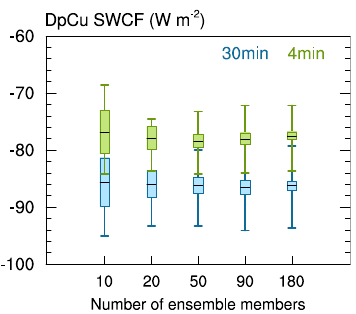
Figure 7. Shortwave cloud forcing (SWCF) associated with tropical Fig. 7. Shortwave cloud forcing (SWCF) associated with tropical deep convection in simulations performed with 30 (blue) and 4min deep convection in simulations performed with 30min (blue) and (green) time steps. The SWCF is averaged over tropical ocean grid 4min (green) time steps. The SWCF is averaged over tropical ocean points, where the daily mean convective precipitation rate exceeds grid points where the daily mean convective precipitation rate ex- 3mm day − 1 . Like in Fig. 4, horizontal bars in the middle of filled ceeds 3 mmday − 1 . Like in Fig. 4, horizontal bars in the middle boxes indicate the mean value of each ensemble. Lower and upper of filled boxes indicate the mean value of each ensemble. Lower ends of the whiskers correspond to the 10th and 90th percentiles, and upper ends of the whiskers correspond to the 10th and 90th per- centiles, respectively. Filled boxes show the 95% confidence inter- respectively. Filled boxes show the 95% confidence interval of the val of the ensemble mean. Further details are explained in Sect. 3.3. ensemble mean. Further details are explained in Sect.